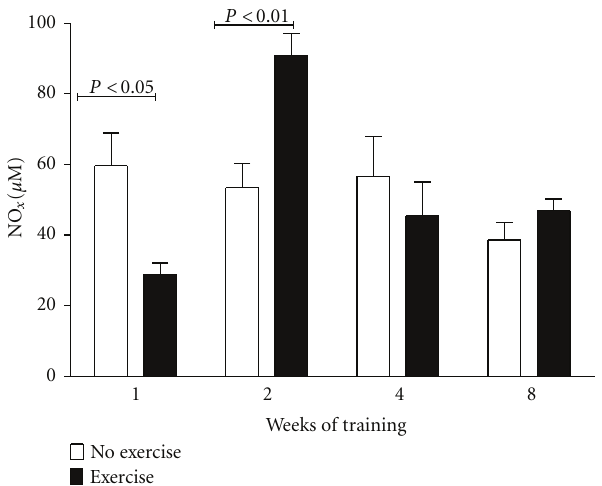
Figure 1: Adaptation to exercise. Plasma reduced nitrate (NO x ) levels decreased significantly one week after training, whereas they significantly increased two weeks after training and returned to normal levels 4 weeks after training (with no changes thereafter). The return to normal is considered adaptation to exercise. Data were analyzed using the two-way ANOVA test and the Bonferroni test post hoc . Data are shown as the mean ± standard error of mean ( n = 6 per group).